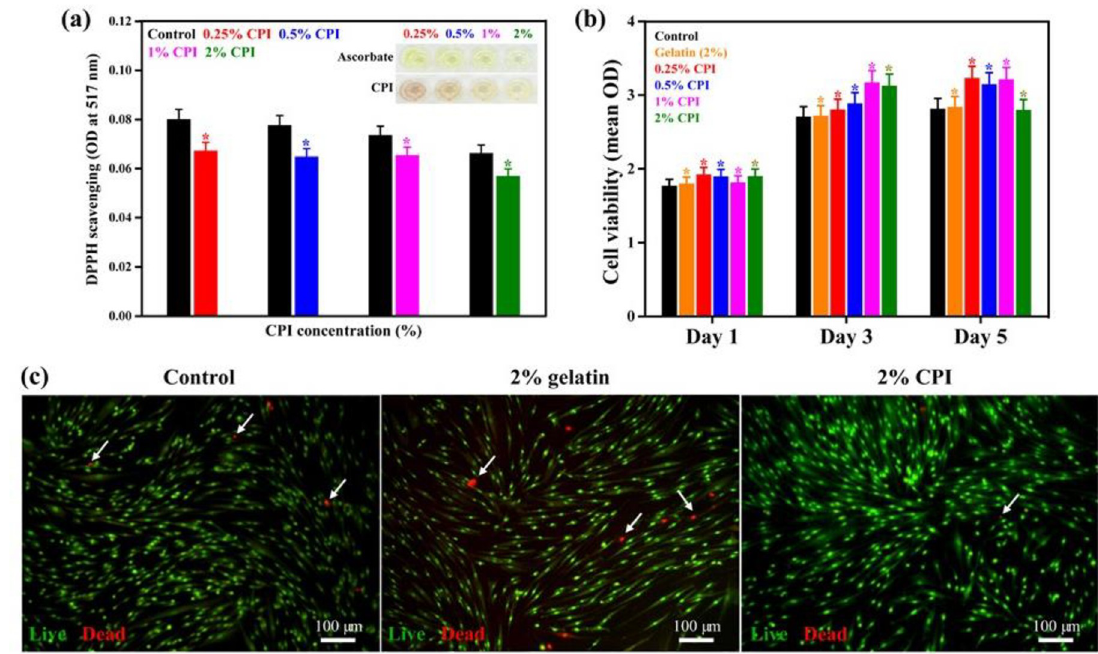
Fig 4. Antioxidative property and biocompatibility of CPI. (a) DPPH scavenging activity of CPI in reference to an equivalent concentration of ascorbate with corresponding digital photographs of the plates (inset). (b) In vitro cytotoxicity evaluation WST-1 assay of CPI-treated hBMSCs. (c) Live/dead assay of 2% CPI-treated hBMSCs after 3 days of incubation (Scale bar: 100 μ m). Gelatin-treated plates were considered as positive controls. Data are mean ± SD of triplicated experiments, statistical significance at � p < 0.05.